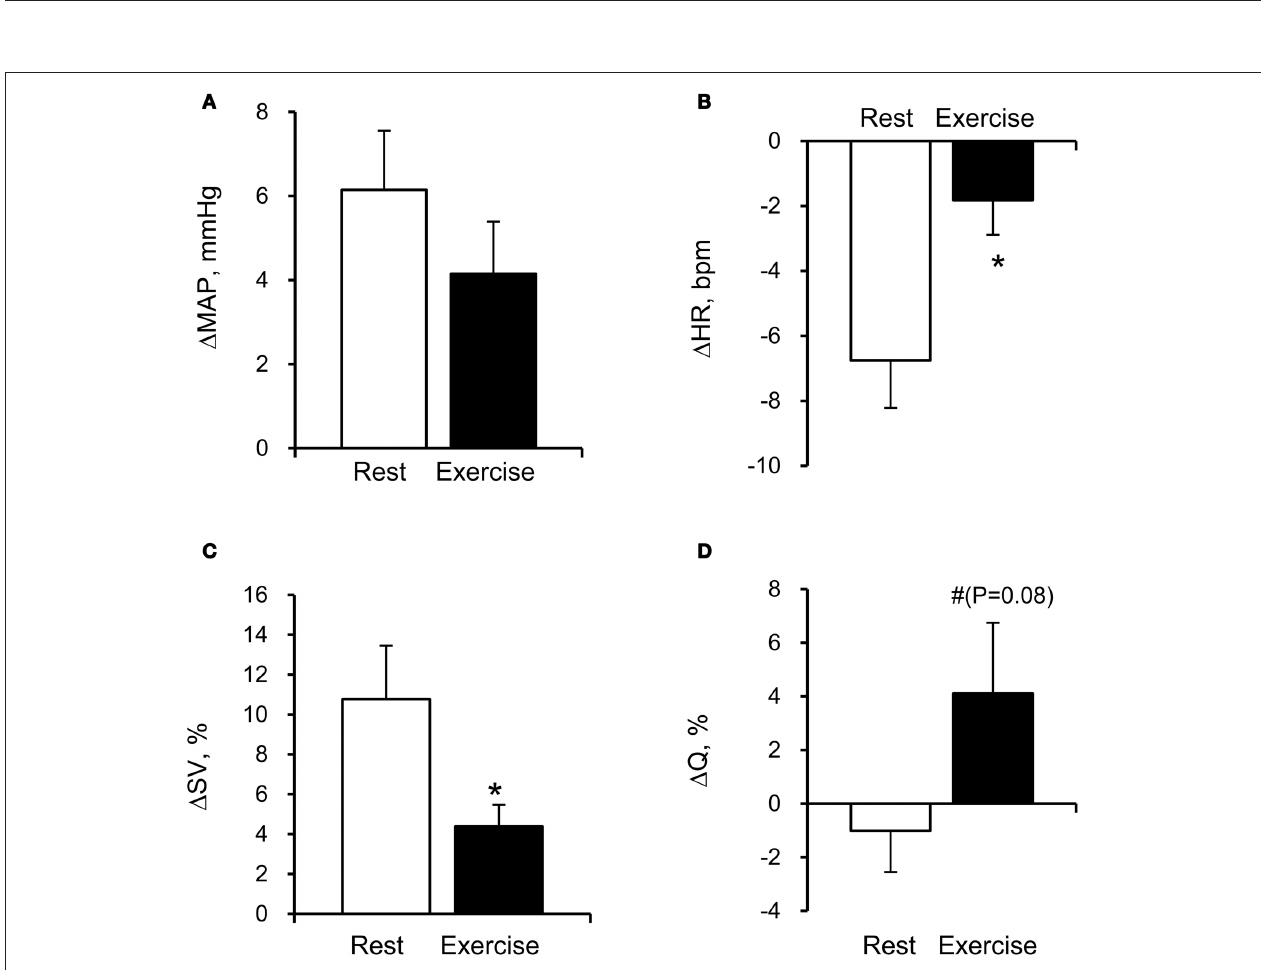
FIGURE 3 | Facial cooling-induced hemodynamic changes ( (cid:2) ) at rest and during exercise: (A) mean arterial pressure (MAP), (B) heart rate (HR), (C) stroke volume (SV), and (D) cardiac output (Q). Values are means ± S.E.M. ∗ P < 0 . 05, # P < 0 . 1 different from rest.